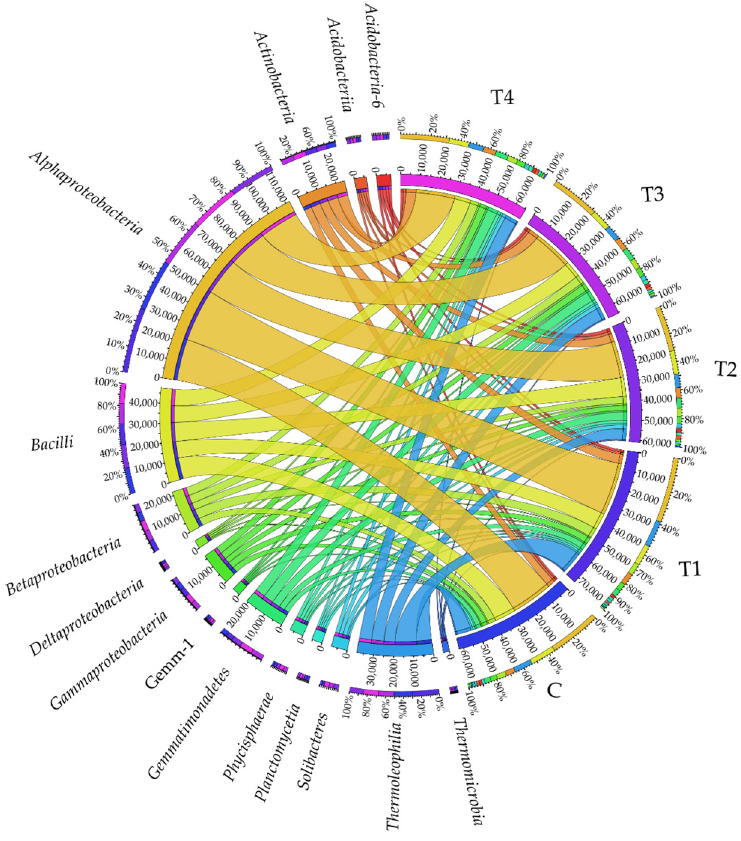
Figure 2. Relative abundance of the predominating bacterial classes in the soils tested with the difference between ratios at ≥ 1%. Tebuconazole doses in mg kg − 1 : C—control soil, T1—0.01 mg,